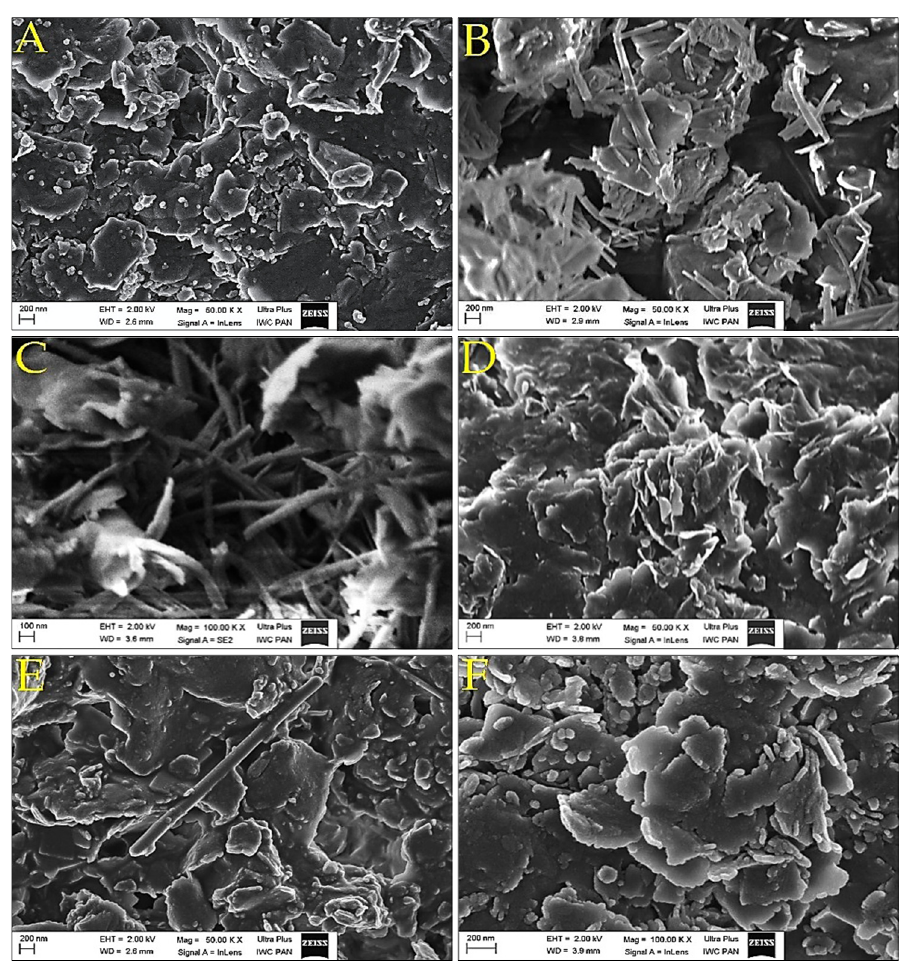
Figure 4. SEM images for montmorillonites: ( A )—Mt, ( B )—Mt-LAc, ( C )—Mt-LAc-CAc, ( D )—Mt- LAc-MA, ( E )—Mt-LAc-PT, ( F )—Mt-LAc-SAc.